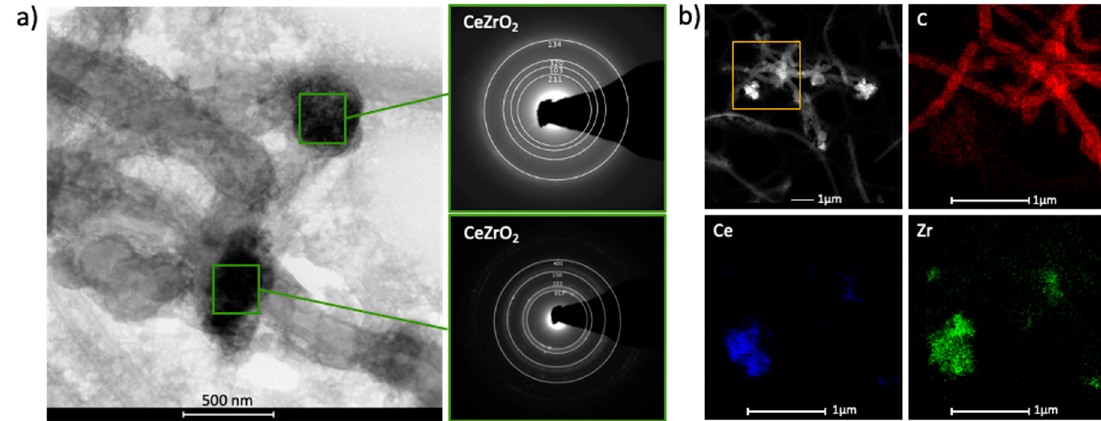
Figure 2. Bright field transmission electron microscopy (TEM) with selected area electron diffraction (SAED) ( a ) and elemental mapping for C, Ce and Zr ( b ) in CZ/CFF sample.